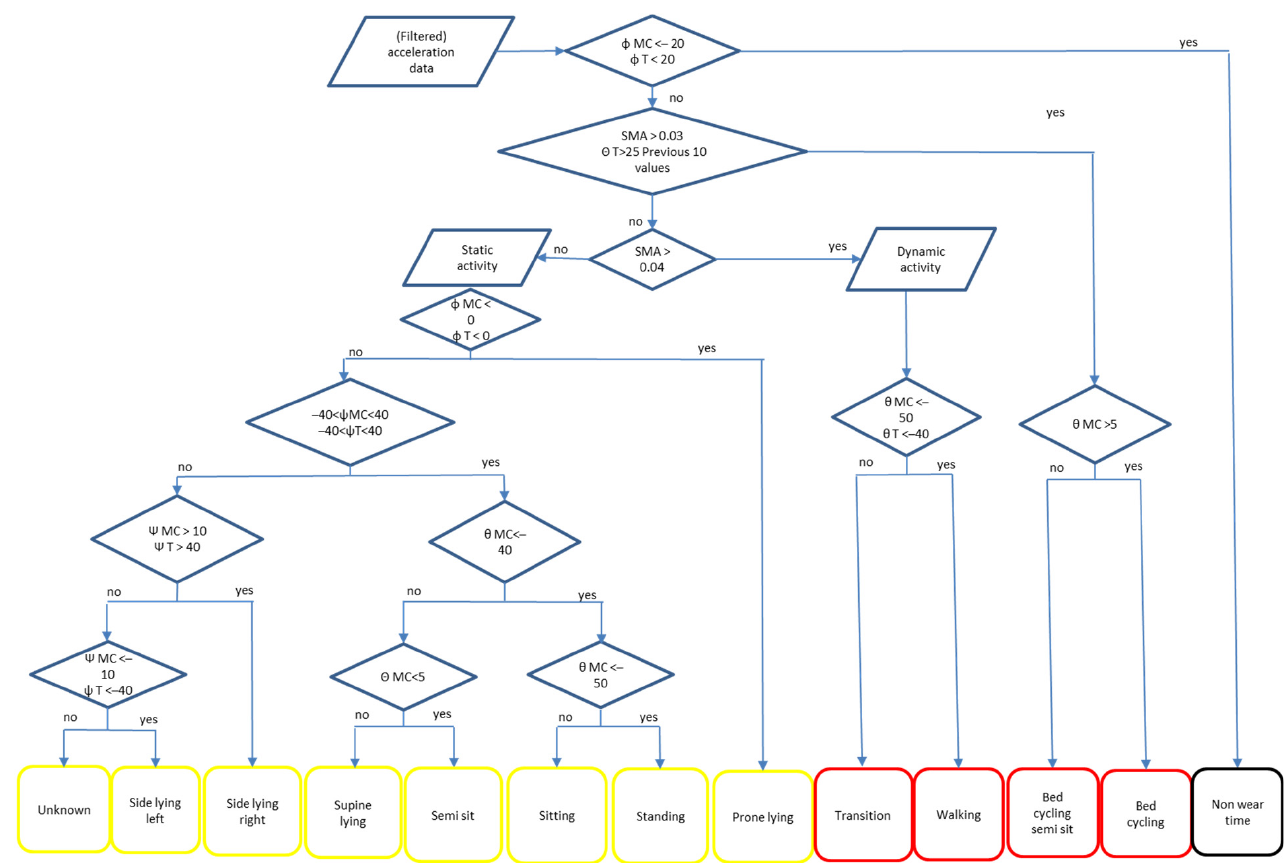
Figure 3. Flow chart of the developed algorithm for classification of the different activities based on body-segment-angles and SMA values of the different accelerometers. Activities in yellow and red are related to smaller and larger bodily movements, respectively. Abbreviations: SMA = signal magnitude area, MC = midclavicular accelerometer, T = thigh accelerometer, θ = theta, ψ = psi, φ = phi.